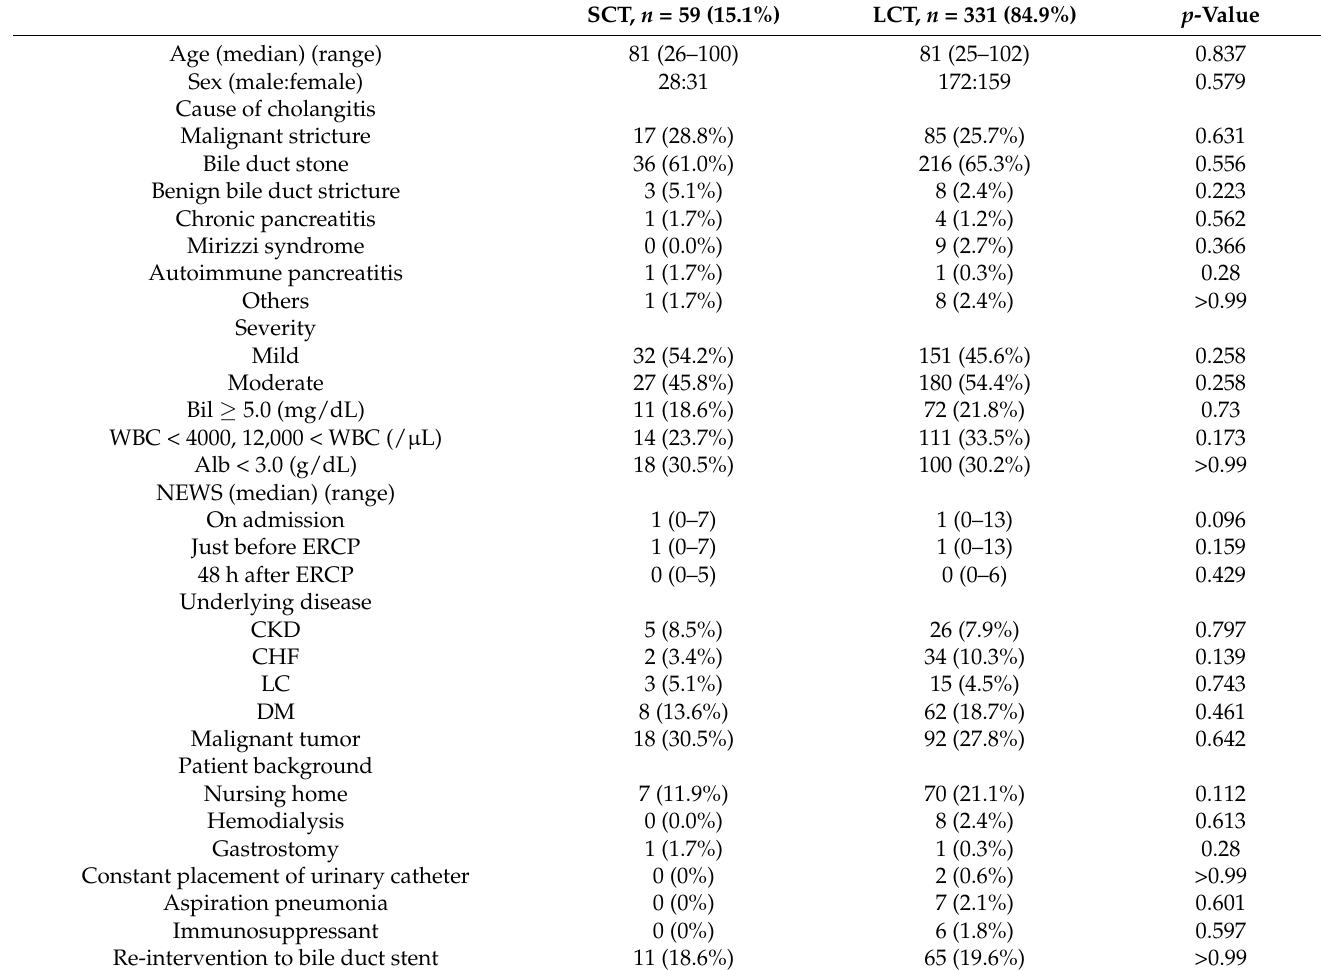
Table 1. Patient